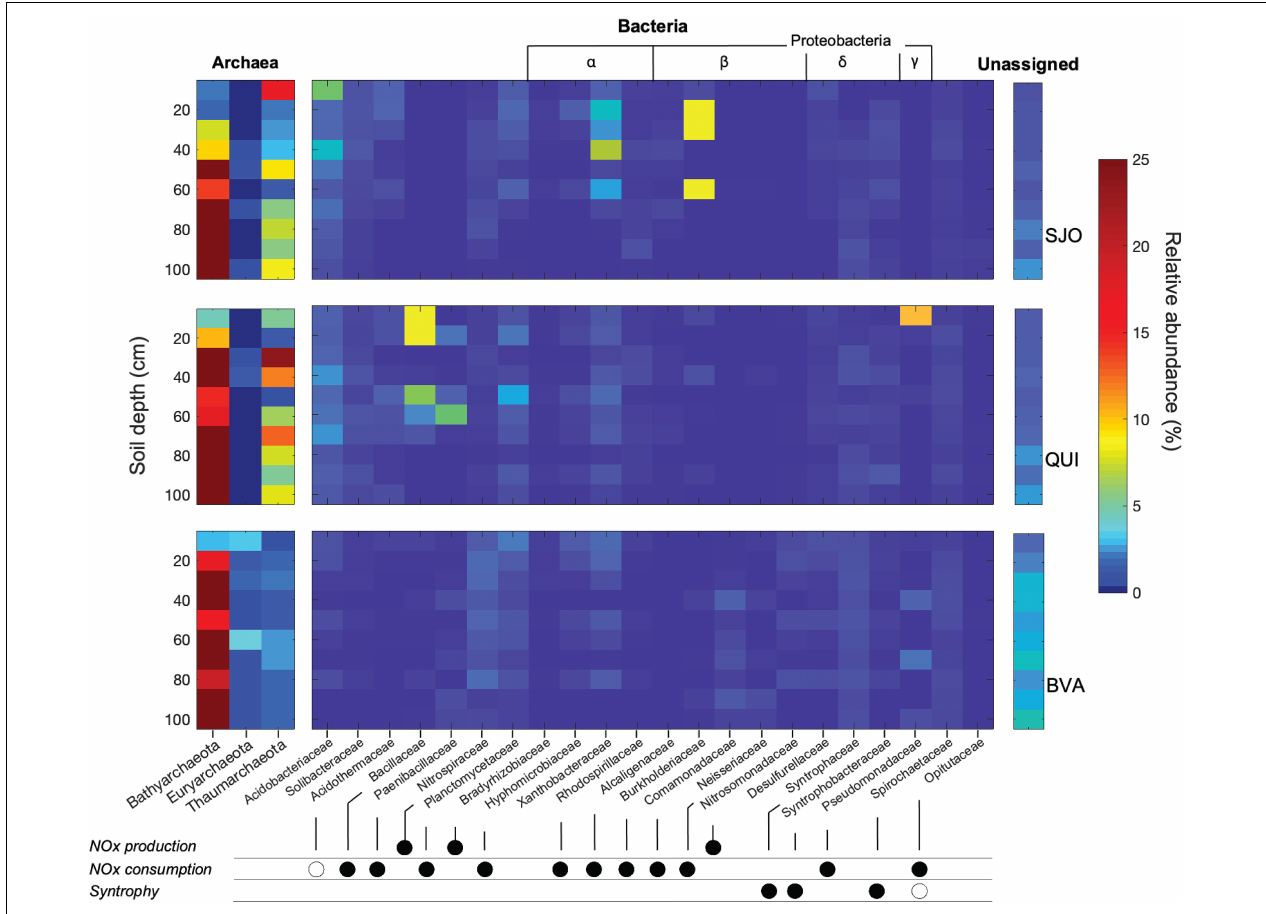
FIGURE 2 | 16S rRNA gene relative abundance heatmap of archaeal (left) and bacterial (right) taxa with known nitrogen metabolic potential. Archaeal 16S rRNA gene relative abundances were summarized on the phylum level with Bathyarchaeota, Euryarchaeota, and Thaumarchaeota consistently making up > 90% of all archaeal taxa. Only bacterial taxa at the family level that were either most dominant (at least 2% of total OTUs), had the potential of a syntrophic relationship to methanogens, or were affiliated to known metabolic reactions involving NO x are depicted. Confirmed metabolic capacities to produce NO x , consume NO x , or for a syntrophic lifestyle are marked with closed circles. Hypothesized metabolic capacities (unsupported by pure cultures) are marked with open circles. The number of unassigned sequences (no match in the SILVA database) increased notably in deeper layers. Relative abundances for individual cores and bacterial metabolic capacities at the family level are provided in Supplementary Table 1 .